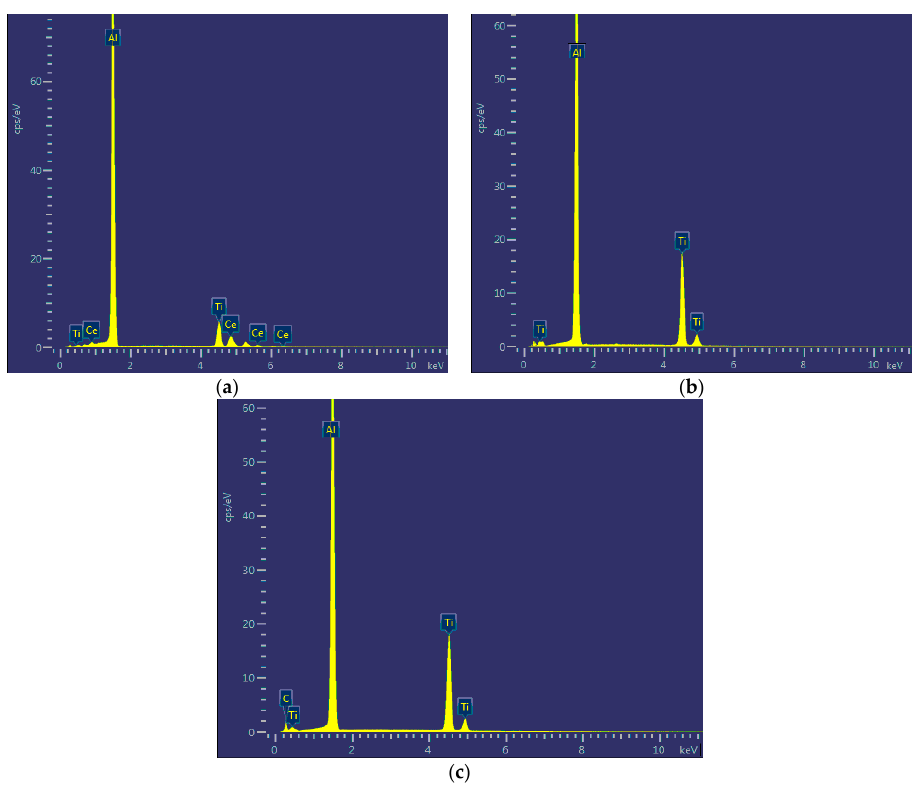
Figure 3. EDS composition analysis of points A, B and C in Figure 2: ( a ) Point A; ( b ) Point B; and ( c ) Point C.